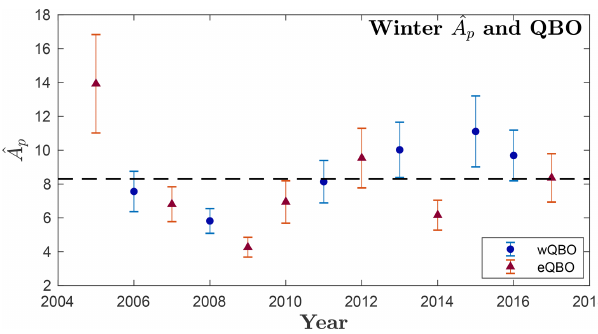
Figure 2. Mean wintertime A p ( ˆ A p ) for each year of this study with the error bars indicating 2 times the standard error of the mean ( ± 2SEM). The dashed line indicates the average ˆ A p for this study (8.3). The direction of the QBO at 25hPa in May is indicated: red triangles represent the eQBO, and blue circles represent the